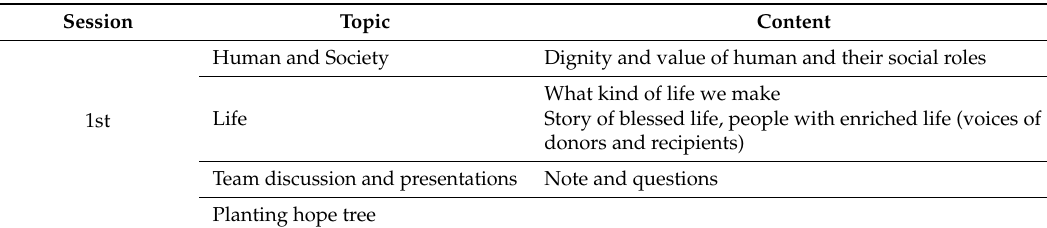
Table 1. Contents of the education program for hematopoietic stem-cell donation